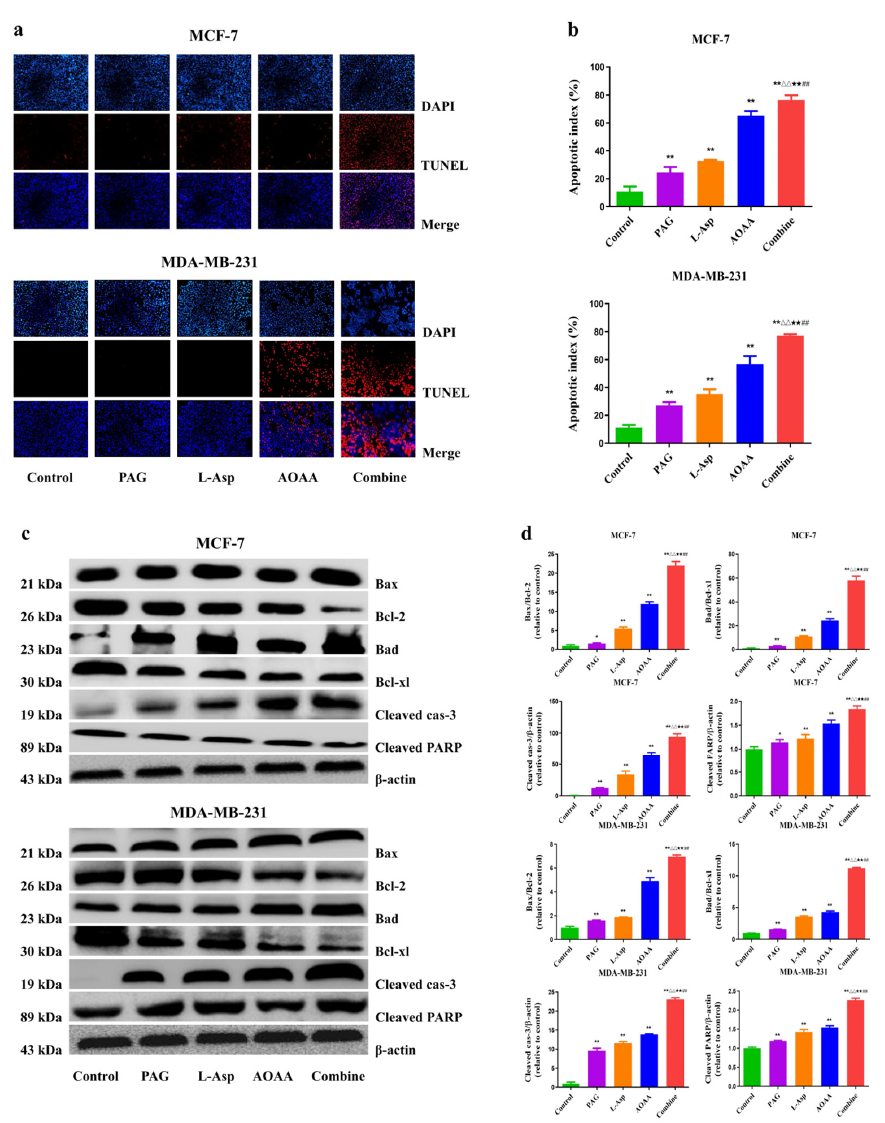
Figure 3. Effects of PAG, AOAA, and L-Asp on the cell death of human BC cells ( a ) The apoptotic level was measured by TUNEL staining (original magnification × 200). ( b ) Apoptotic index was calculated. ( c ) The expression levels of Bax, Bcl-2, Bad, Bcl-xl, cleaved caspase-3, and cleaved PARP were detected by Western blot. β -actin was used as a loading control. ( d ) Densitometric quantification was performed, normalized to the level of β -actin. The experiments were performed in triplicate. Data are presented as mean ± SEM. ** p < 0.01 compared with the control group; (cid:52)(cid:52) p < 0.01 (cid:70)(cid:70) p compared with PAG group; < 0.01 compared with AOAA group; ## p < 0.01 compared with L-Asp